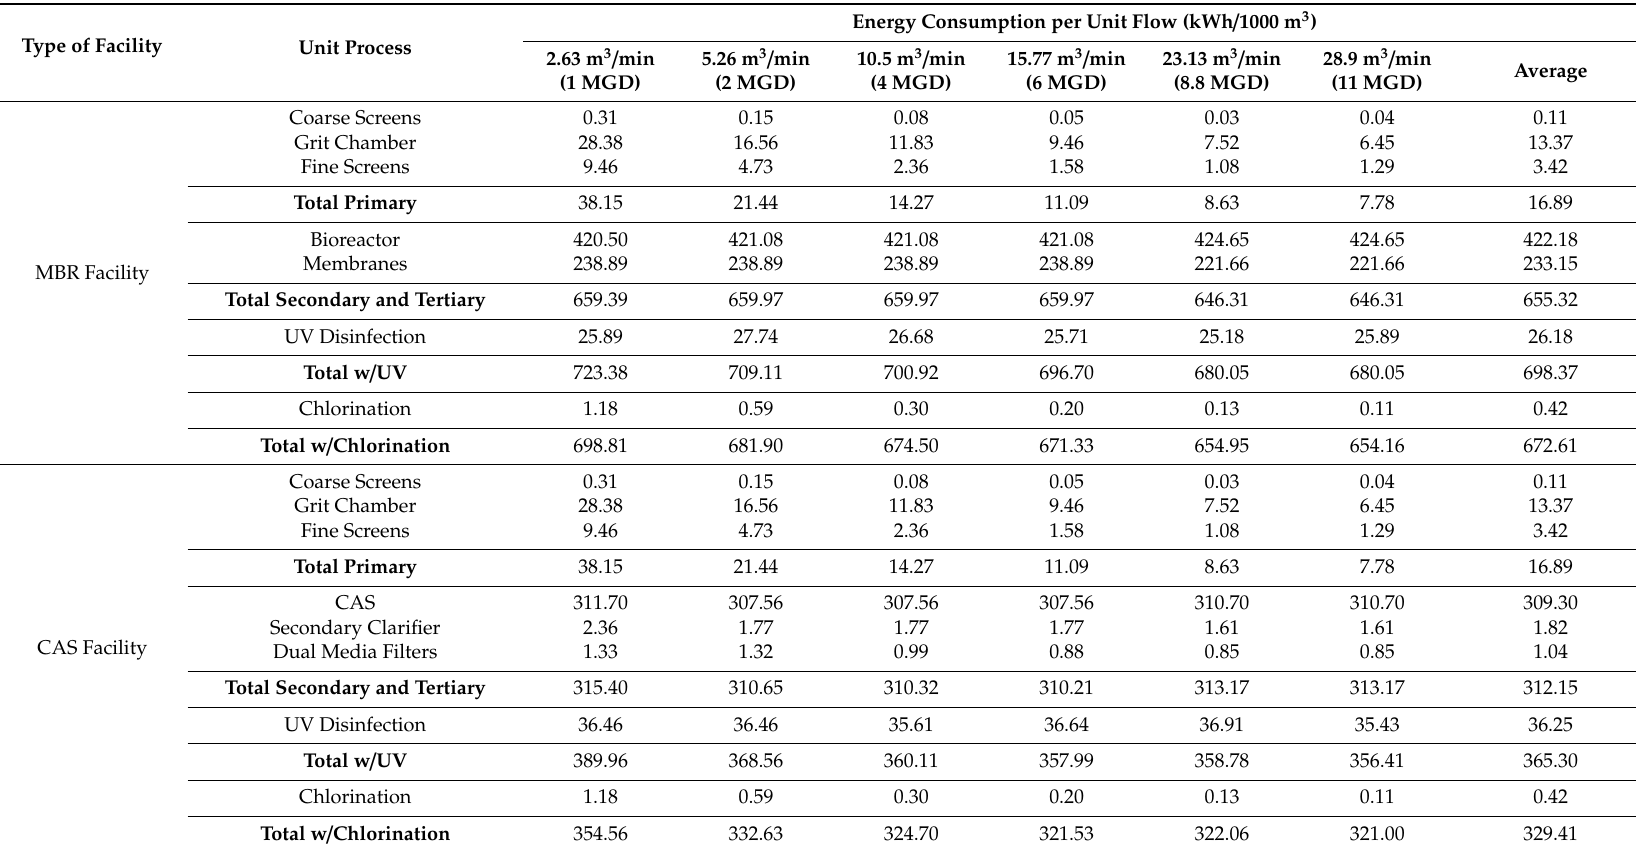
Table 2. Energy Consumption of Each Unit Process per Unit Flow (kWh / 1000 m 3